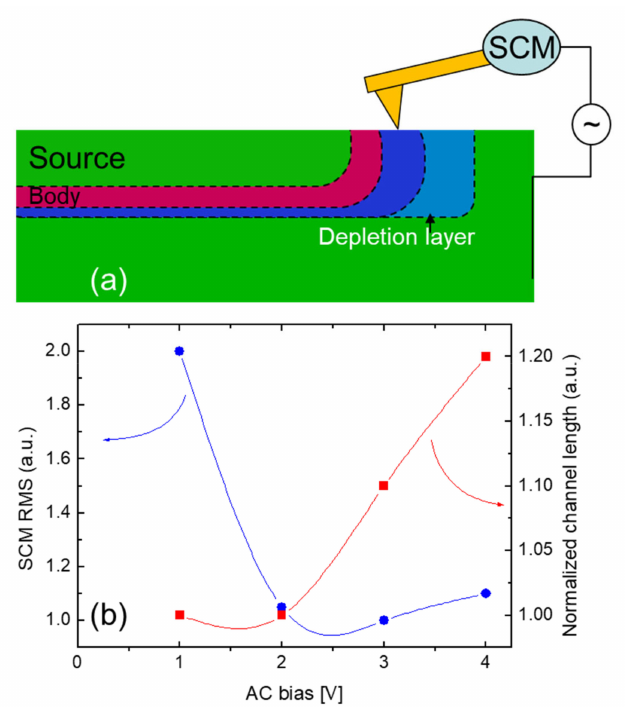
Figure 4. ( a ) Schematic description of the SCM tip influencing the depletion region at the p–n junction. ( b ) SCM RMS and normalized channel length vs. SCM tip AC